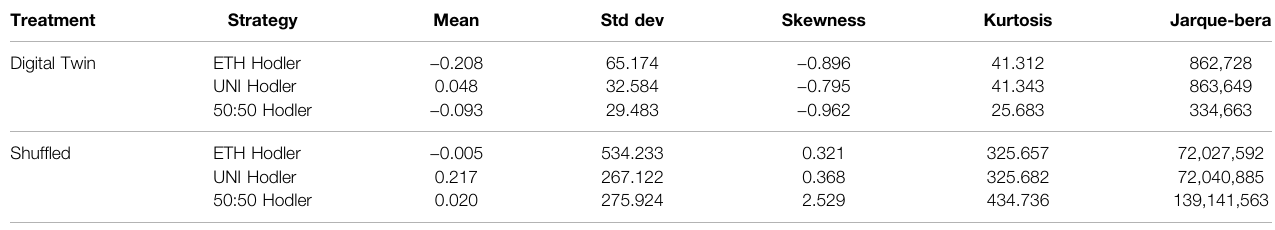
TABLE 3 | Stylised Facts of hourly price returns.